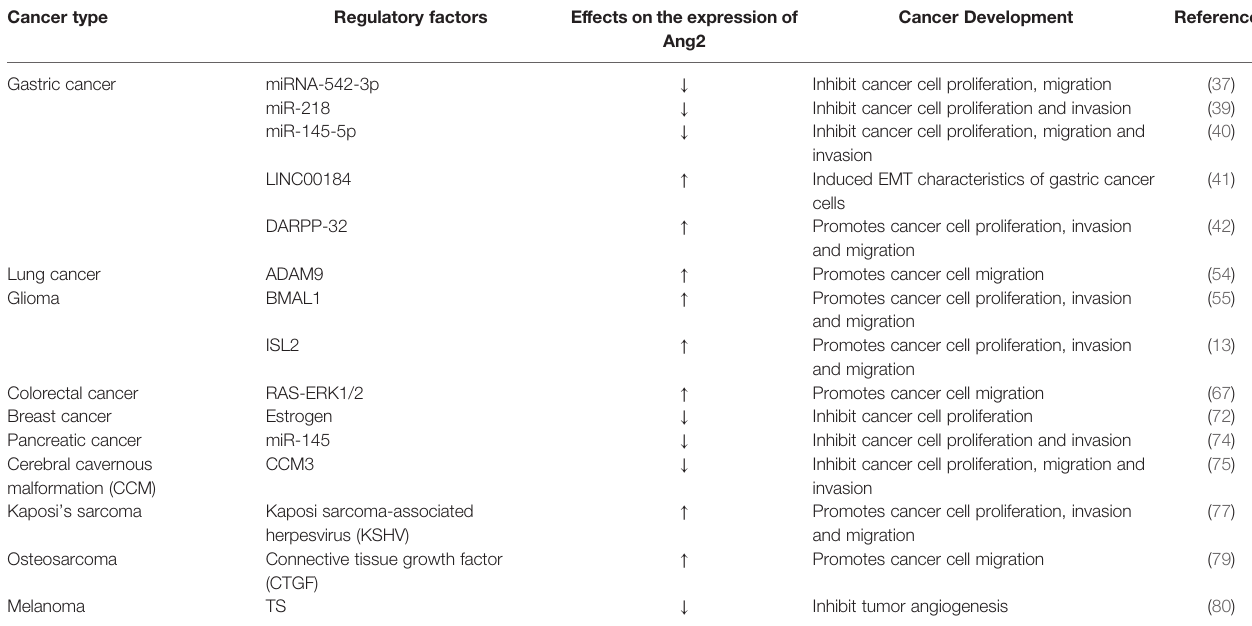
TABLE 2 | Dysregulated Ang2 in